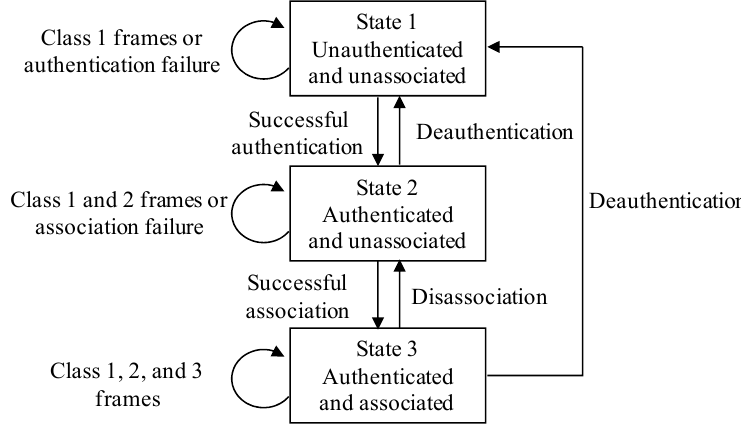
Figure 2. Overall 802.11 state diagram.